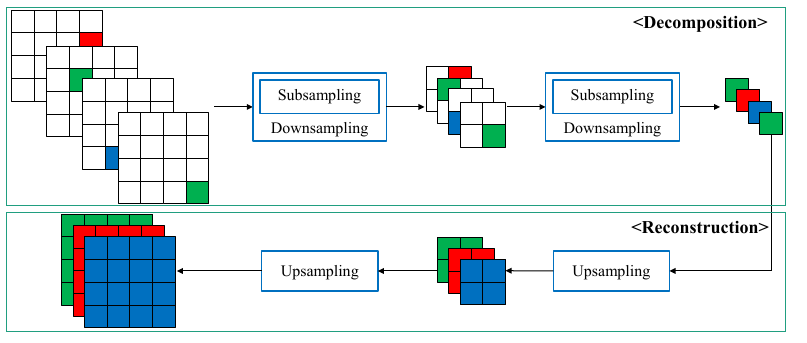
Figure 4. Structural similarity of subsampled Canon-RGBW CFA and Laplacian